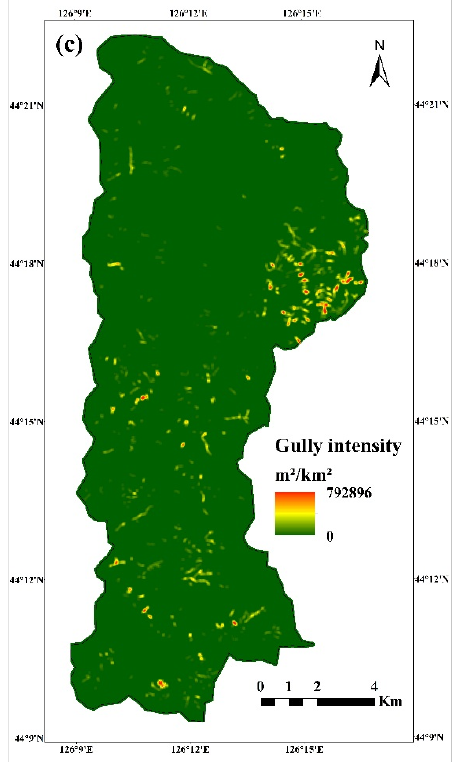
Figure 2. The distribution map of: ( a ) erosion gullies; ( b ) gully density; and ( c ) gully intensity in the study area.